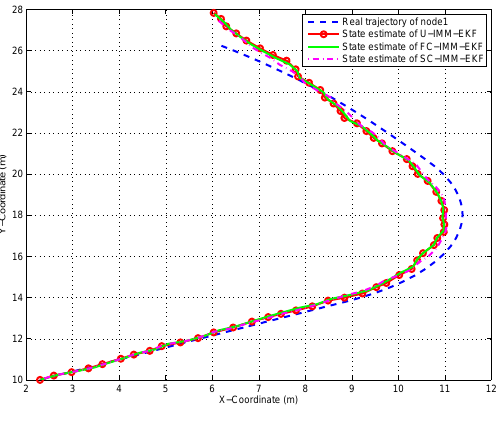
Figure 10. Estimate error of node